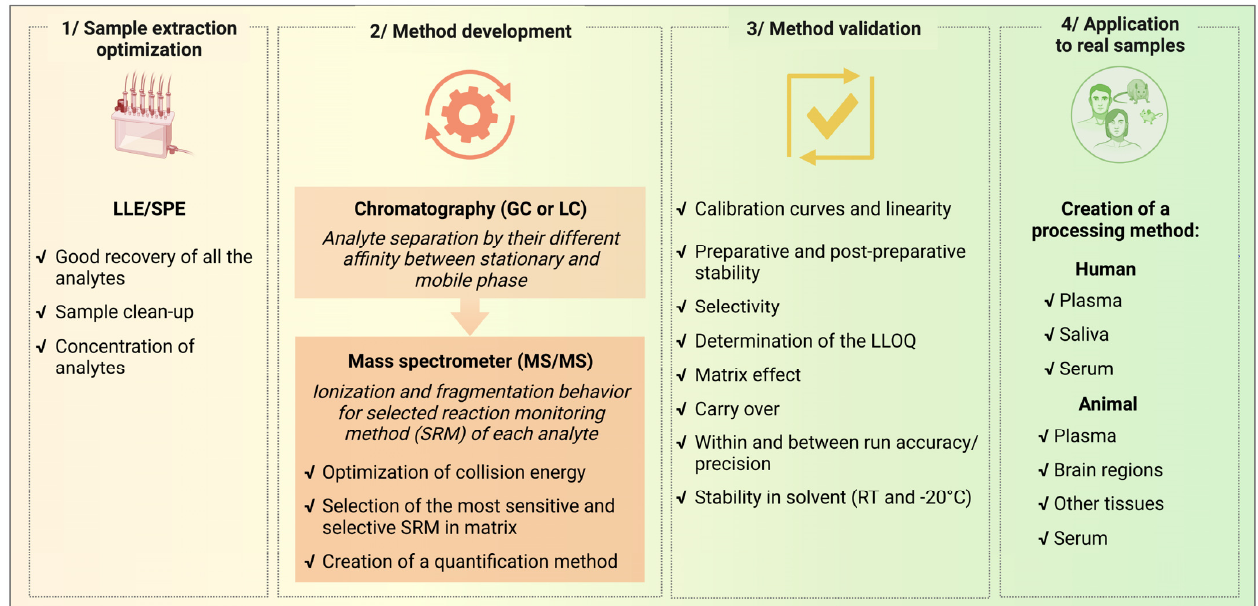
Figure 3. Pre-analytical and analytical phases of the validation process. The steps of the methods include 1/sample extraction optimization, 2/mass spectrometry method development, 3/the validation process of the method, and 4/the application to real biological samples in human and animal models.